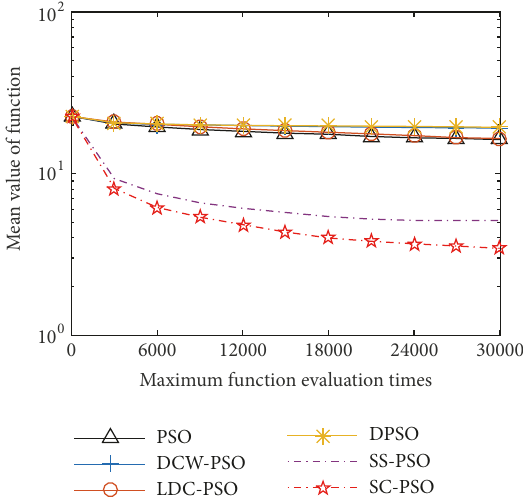
Figure 10: The function f 8 iterates over the curve.